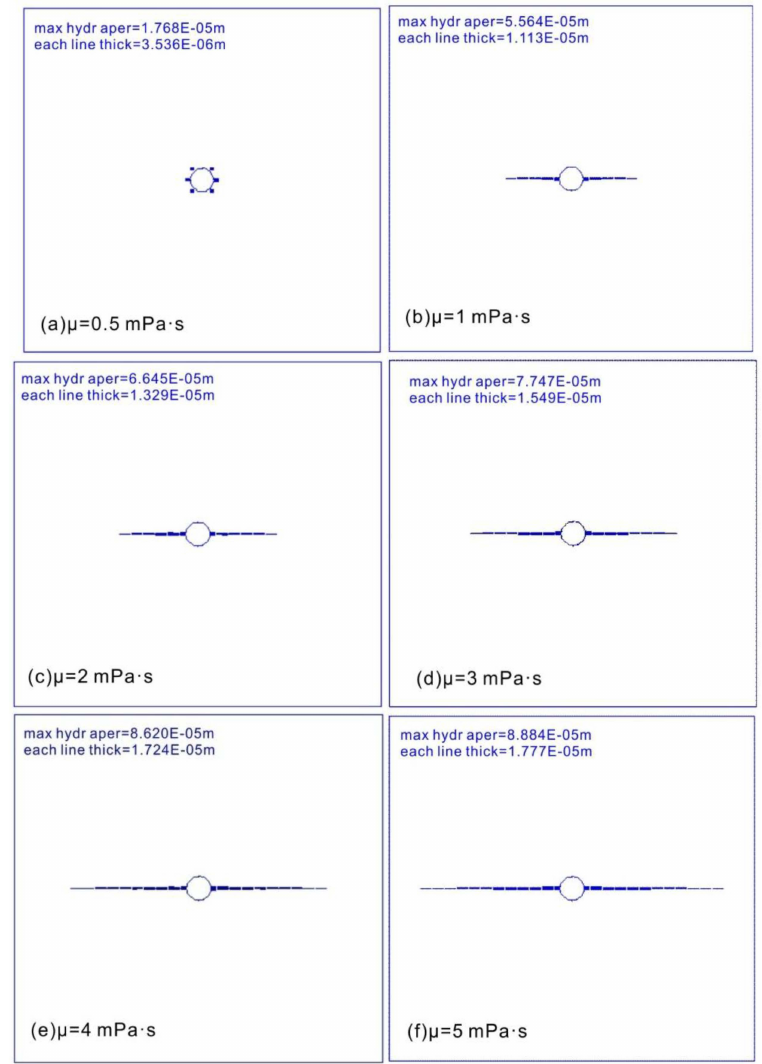
Figure 10. The relationship between hydraulic fracture geometry and injection fluid viscosity.